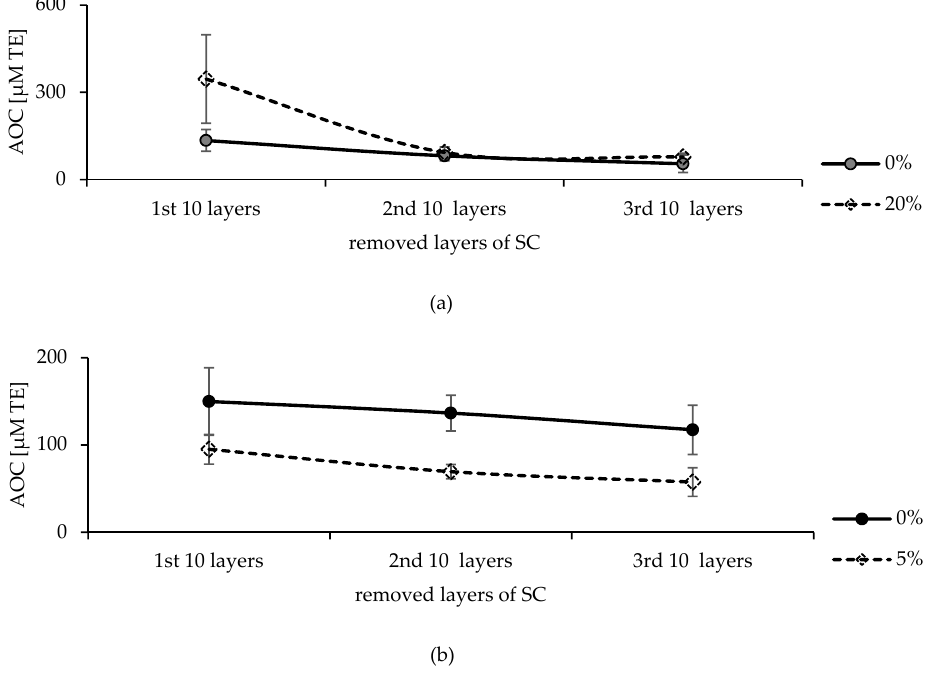
Figure 10. AOC of the removed SC layers after treatment with ( a ) AA solution (20% (w/v)), and ( b ) CoQ10 solution (5% (w/v)), compared to untreated SC layers.